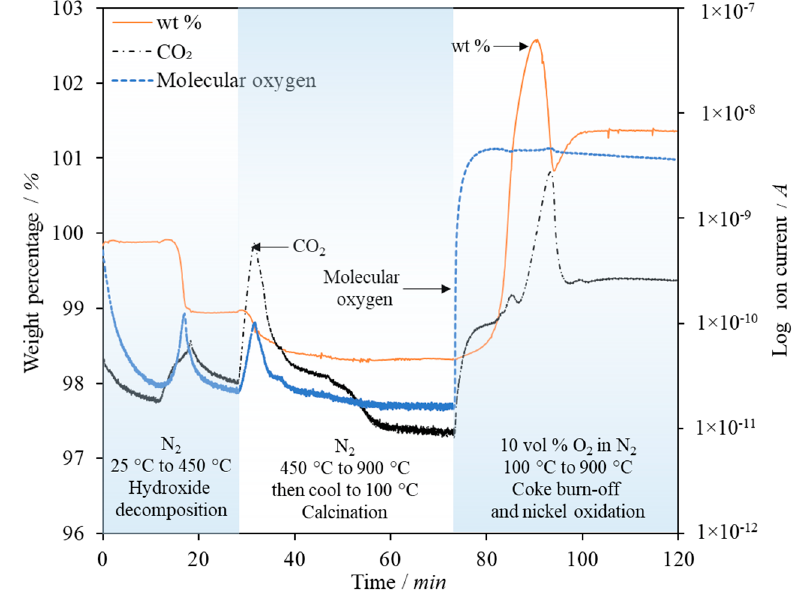
Figure 10. Thermogravimetric Analysis (TGA) weight change as a percentage of the initial mass and mass spectrometer response for CO 2 and molecular oxygen for a sample of coked combined particles composed of CaO and Ni (21 wt % Ni), post Sorption Enhanced Steam Reforming (SESR) but prior to calcination and burn off.